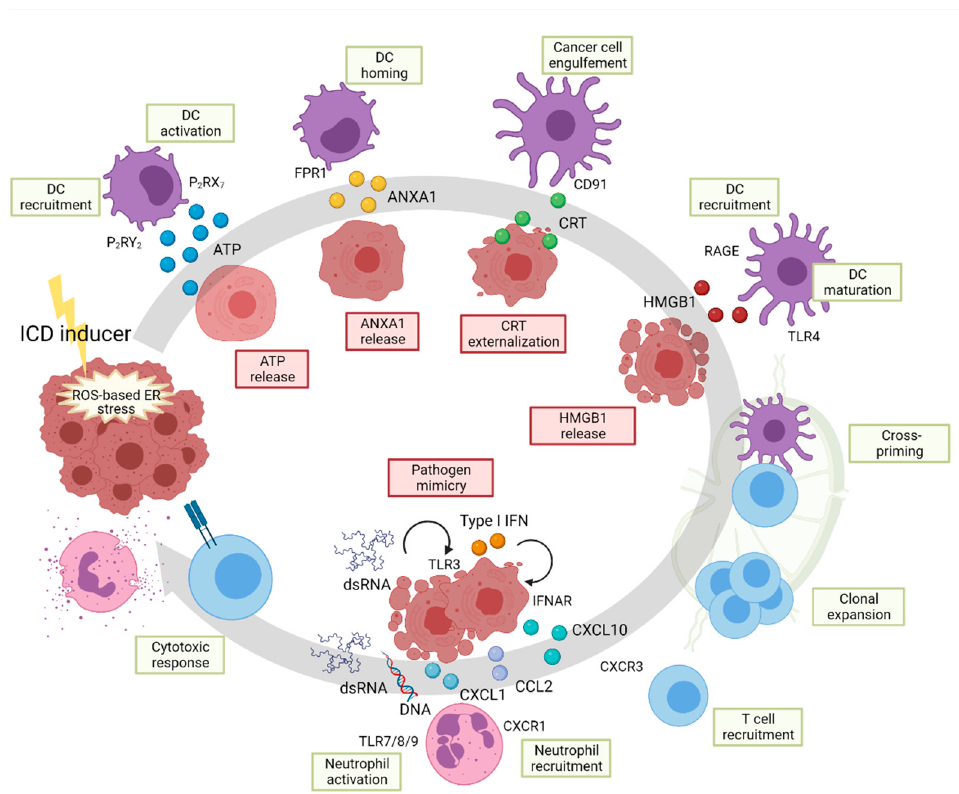
Figure 4. Immunogenic cell death (ICD). Upon treatment with ICD inducers, cancer cells experience ER stress caused by ER-associated ROS production that favors DC recruitment and activation through secretion of ATP (by binding to purinergic receptors P2RY2 and P2RX7, respectively) and their homing with released annexin A1 (ANXA1) binding to FPR1. Surface exposure of CRT stimulates the phagocytosis of dying cancer cells by engaging the CD91 receptor on DCs. In the late apoptotic phase, HMGB1 release recruits further DCs by binding RAGE receptor and induces their maturation through TLR4 signaling. DCs then migrate to the lymph node where they cross-prime and favor the clonal expansion of T cells. Cancer cells dying of ICD can mimic a pathogen infection response by releasing RNA that autocrinally induces type I IFN production and CXCL10 secretion (favoring the recruitment of tumor-specific T cells through CXCR3) and induce neutrophil recruitment and activation by releasing the chemokines CXCL1 and CCL2 as well as DNA and RNA. T cells and neutrophils then mediate the killing of live residual tumor cells.